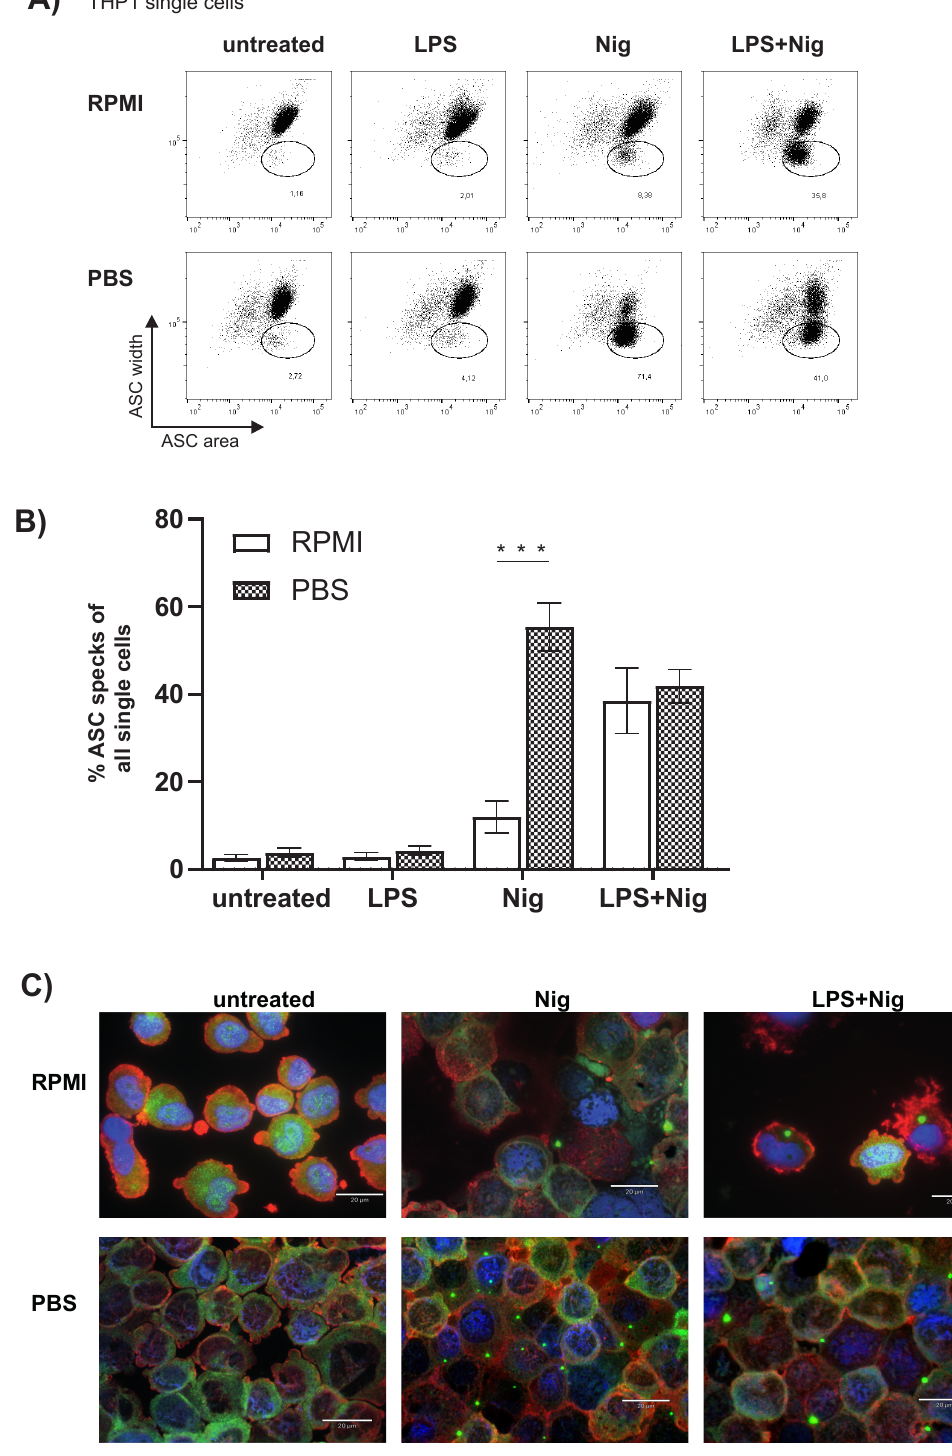
Figure 5. Incubation with Nig without prior priming results in the formation of ASC speck + cells in THP1 cells. ( A ) Representative dot plots and ( B ) quantification of data of THP1 cells for intracellular ASC. THP1 cells were stimulated as indicated in ( A ). ( C ) Fluorescence microscopic images of ASC specks in THP1 cells stained as described in 3C) either left untreated or stimulated as indicated (scale bar 20 µ m). A two-way ANOVA, followed by a Bonferroni multiple comparison test was performed. A p -Value *** p < 0.001 was considered significant ( n = 4 measured as triplicates and represented as the mean value from these, from four independent experiments, shown mean ±